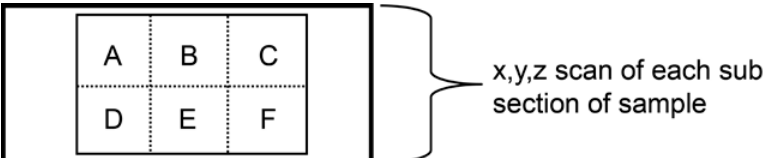
Figure 1. Slide preparation and imaging scheme. Population Z-series scans are obtained by scanning immobilized Fremyella diplosiphon cells in the x, y, and z axes for each sub-section of the cover-slip covered area (e.g., A, B, C, D, E, and F) on a